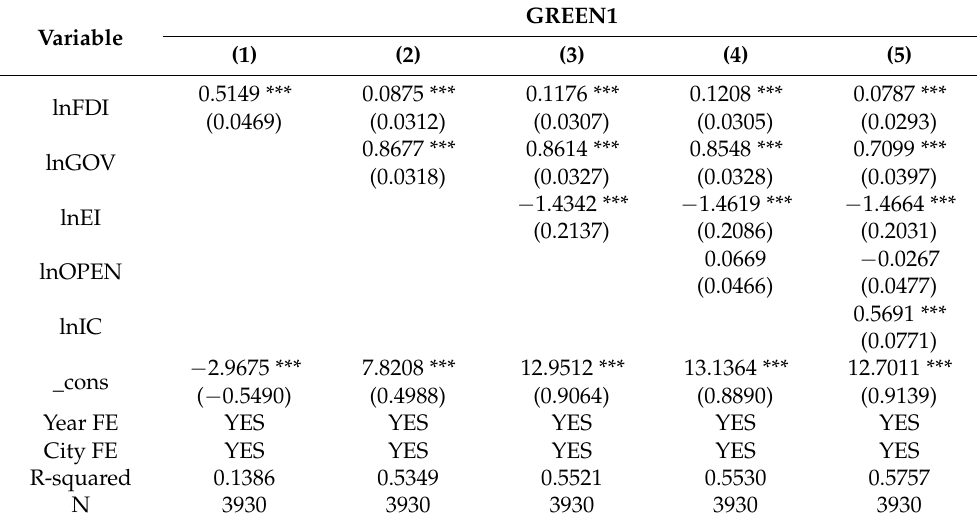
Table 2. Baseline regression